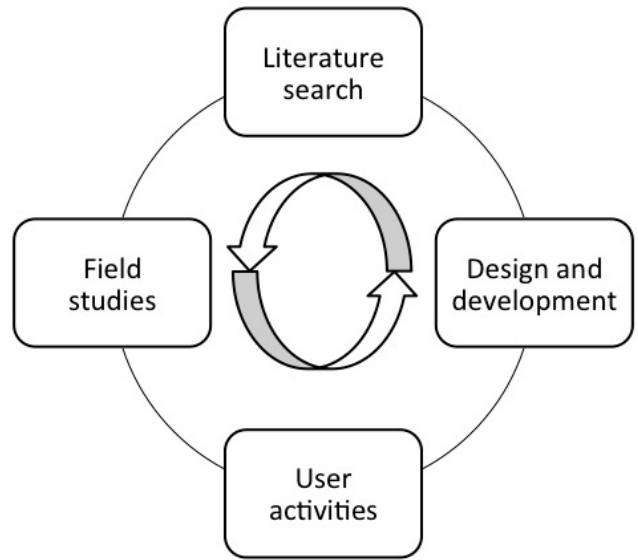
Figure 1. The ongoing and parallel activities in the participatory design process. Inspired by Clemensen [28].